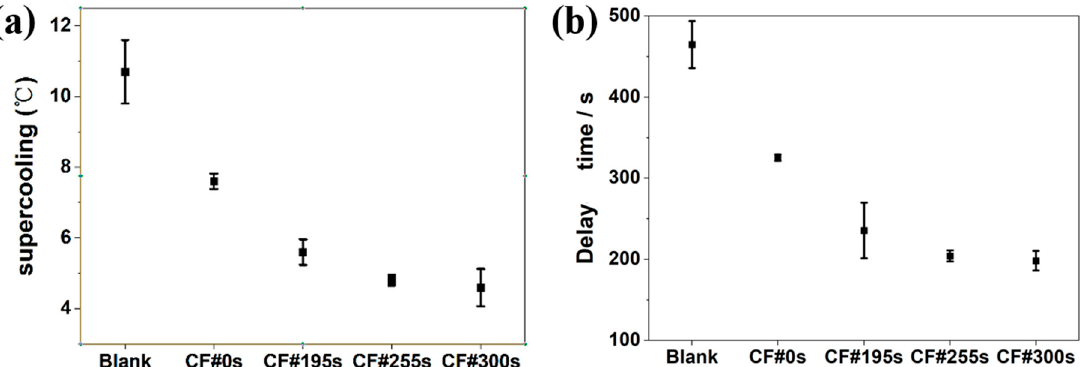
Figure 5. Supercooling and delay time during the solidification process ( a ) supercooling; ( b ) delay time.